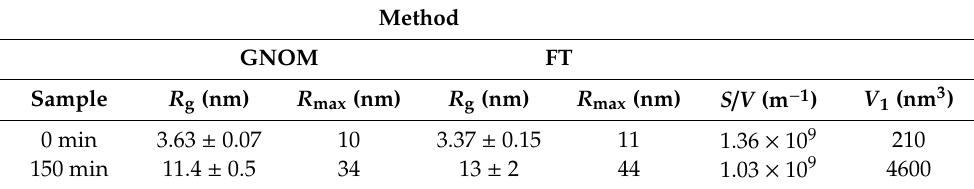
Figure 5. The p ( r ) functions for the initial (solid line) and 150 min solutions (blue triangles) calculated using the Fourier transform method. The p ( r ) function calculated for a triangular model prism (red dashed line) is shown for comparison. The model is shown in the inset. Table 1. Structural parameters of the initial solution and the 150 min illuminated solution estimated from small-angle X-ray scattering (SAXS) data by indirect GNOM and Fourier transform (FT) methods. R g is the radius of gyration, R max the maximum dimension, S / V the surface-to-volume ratio, and V 1 the average volume of a single